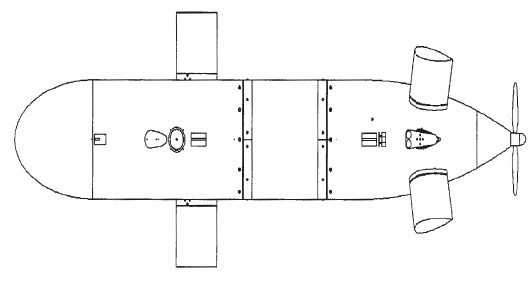
Figure 1: Hull structure of the MUN Explorer